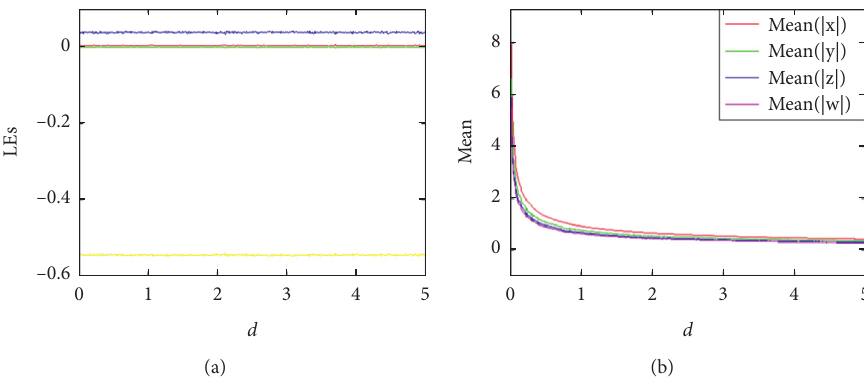
������ 􏽰 ������ 􏽰 Figure 14: Dynamical evolution of system (1) with (a) � 0.8; (b) � 0.5; (c) � 1 and initial condition ( ( 0 . 01/ ( 0 . 1/ d ) ) , ( 0 . 01/ ( 0 . 1/ d ) ) , 0, 0), when (d) varies in [0, 5]: (a) Lyapunov exponent spectrum and (b) average values of the absolute value of the chaotic signal. ( 0 . 0109 , 0 . 0109 , 0 , 0 ) ; and d � 0 . 25is green while the initial Figure 17 represents the phase portrait where the conditions are ( 0 . 0158 , 0 . 0158 , 0 , 0 ) . hyperjerk chaotic system signals x , y , z , and w are repre- Figure 19 and Table 2 show power utilization and re- sented with 32 bits using the Forward Euler method by source utilization of memristive hyperjerk chaotic system setting h � 0 . 01 with parameter values a � 0.8, b � 0.5, c � 1, obtained using FPGA with the parameter values, d � 0.1 and the initial condition of a � 0 . 08 b � 0 . 5 c � 1 . 05, d � 0 . 1 under the initial condition ( x � 0 . 01 , y � 0 . 01 , z � 0 , w � 0 ) . It can be seen that the 0 0 0 0 ( 0 . 01 , 0 . 01 , 0 , 0 ) . functional hardware results are very similar to MATLAB The power chart of the proposed system gives us in- results. Figure 18 represents the phase portraits of system (1) formation about the different resources and their power with a � 0.8, b � 0.5, c � 1, under the initial condition of ������ 􏽰 ������ 􏽰 ( 0 ( 0 . 01/ ( 0 . 1/ d ) ) , ( 0 . 01/ ( 0 . 1/ d ) ) , 0 , 0 ) . D � 0.08 is red utilization. From the chart, it is observed that the power consumption is extremely less when compare with realizing while the initial conditions are ( 0 . 0089 , 0 . 0089 , 0 , 0 ) ; d � the system on other digital software. 0 . 12 is blue while the initial conditions are